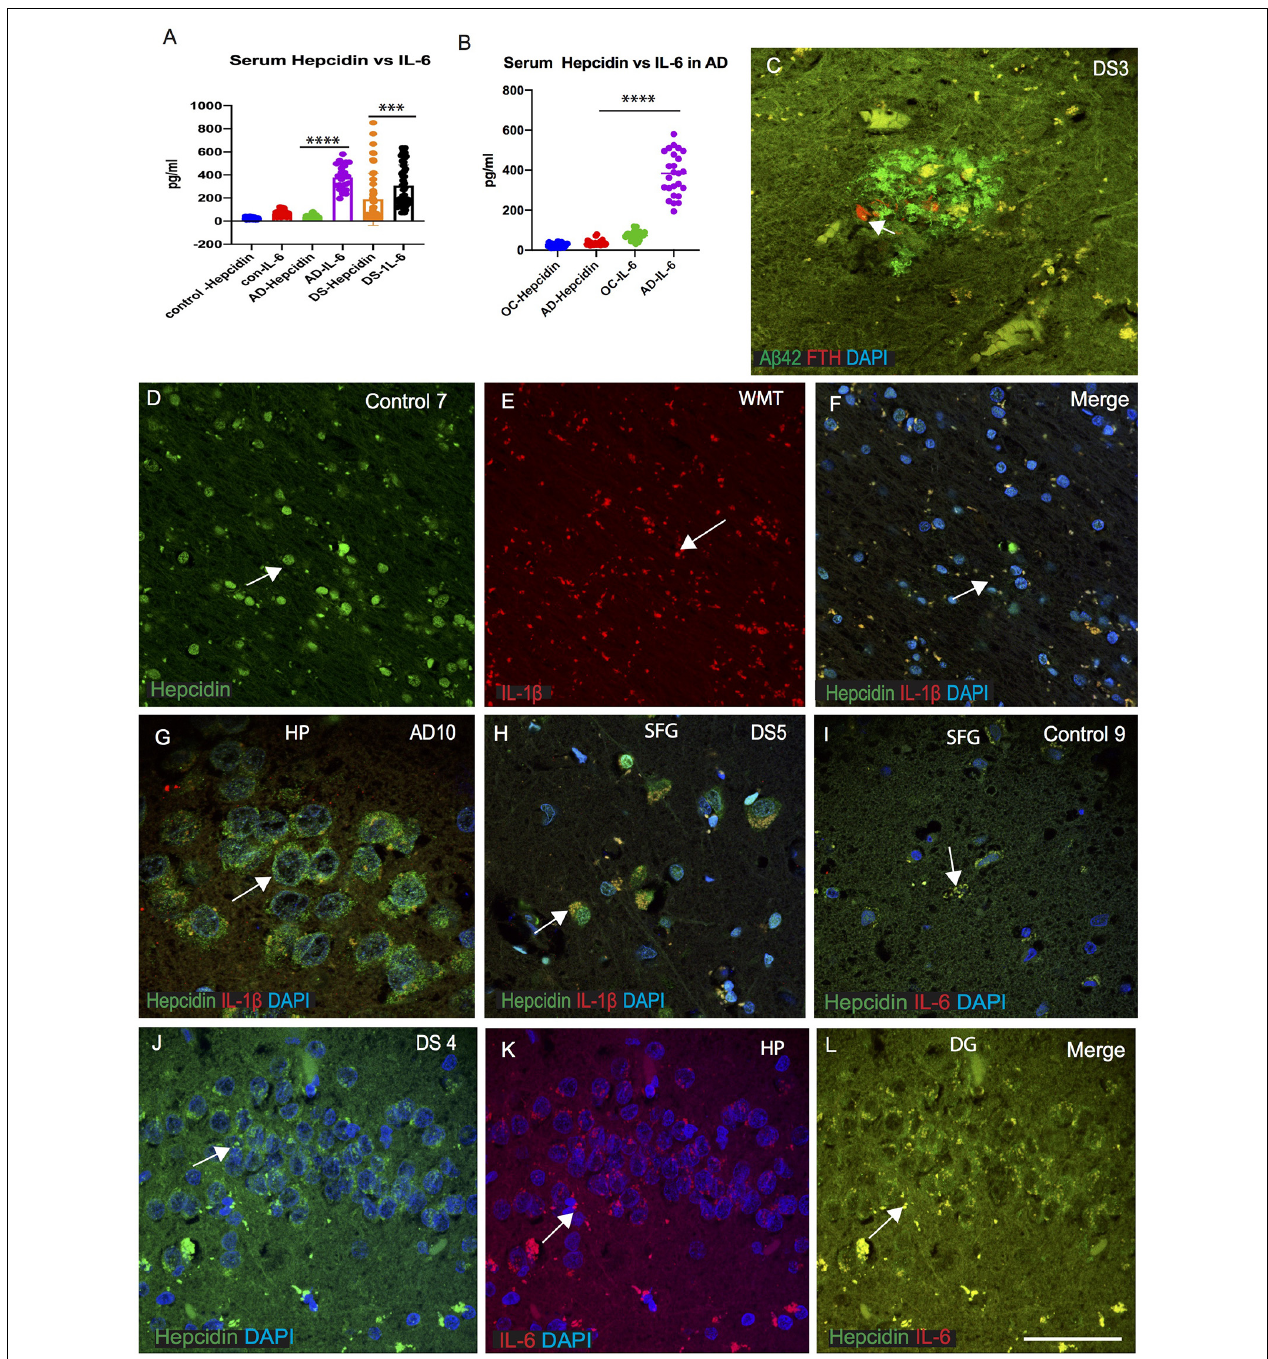
FIGURE 5 | IL-6 could be involved in host defense in AD and DS brain. ELISA based analysis of IL-6 in serum samples showing increased levels in AD and highest level in DS when compared with hepcidin ( p < 0.0001; A ). Samples were analyzed from AD and age matched older controls (OC), IL-6 levels were significantly higher in AD serum ( B ; p < 0.0001). Ferritin (FTH) was present close to a SP in DS brain analyzed by double immunofluorescence, and did not co-localize with A β 42 positive plaques (C) . Another control brain section from white matter tract (WMT) of corpus callosum (CC), labeled with hepcidin, expression being visible in the WMT (in the oligodendrocytes), whereas IL-1 β being present in the microglia with minimal co-localization (D–F) . Brain sections from AD (HP, hippocampus) and DS (SFG) when stained with hepcidin and IL-1 β , revealed similarly the presence of hepcidin (punctuate, vesicular appearance) in the hippocampal neurons, whereas IL-1 β was visible only in the microglia with minimum co-localization (G,H) . When control and DS brain sections of HP and SFG were stained for hepcidin and IL-6, there was less IL-6 visible in the control brain (I) , whereas there was a higher co-localization seen in the granule cells of hippocampus of DS subjects (J–L) . Scale bar: (C and G) = 20 µ m, (D–F) = 50 µ m, (H–L) = 25 µ m. ∗∗∗ p < 0.001, ∗∗∗∗ p < 0.0001.